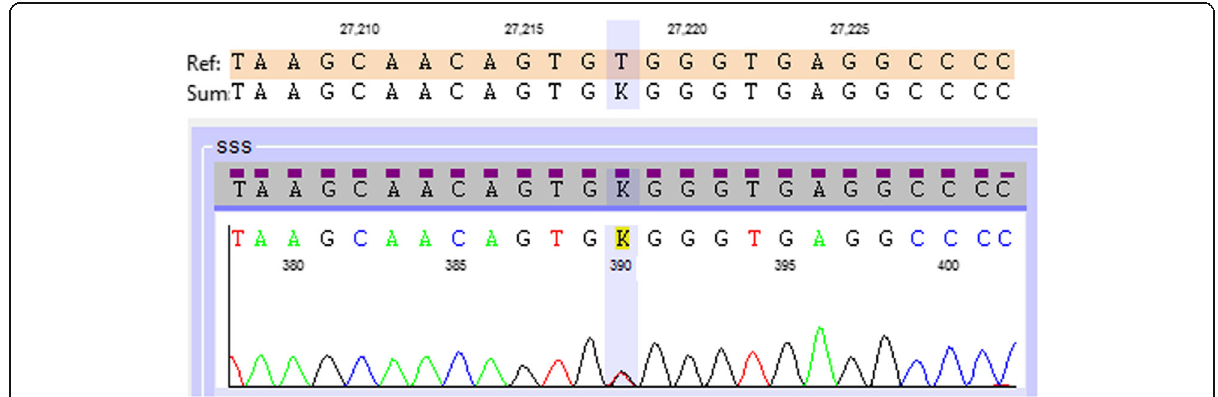
Fig. 4 The schematic diagram shows the variant involving FLC N intron 13 corresponding to an exchange of timine (T) for guanine (G)